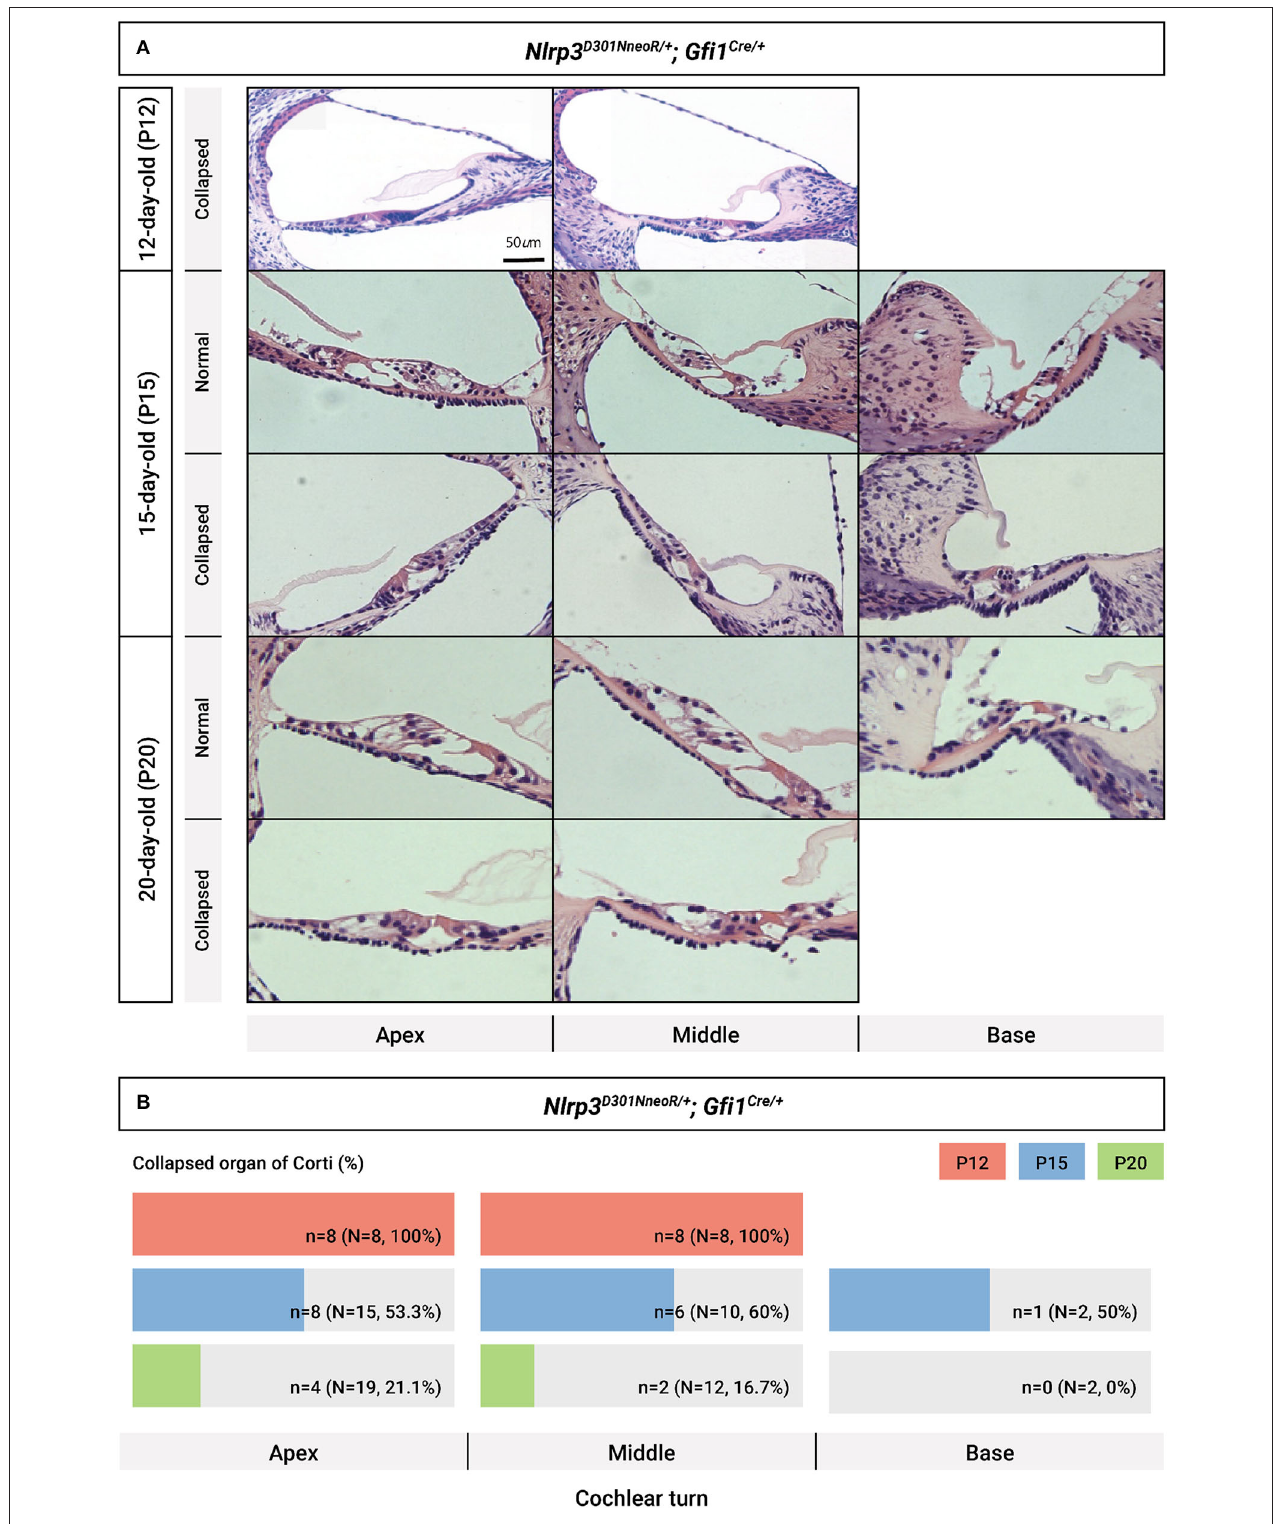
FIGURE 6 | Chronological evaluation of cochlear morphology in Nlrp3 D 301 NneoR / + ; Gfi1 Cre / + mice. (A) Representative sections from the cochlear turns obtained at P12, P15, and P20, respectively, are depicted (normal cochlear morphology vs. collapsed morphology of organ of Corti). (B) Proportion of collapsed organs of Corti at each time point, depending on cochlear turns. The scale bars represent 500mm (P12) and 1,000mm (P15 and P20). P, postnatal day.